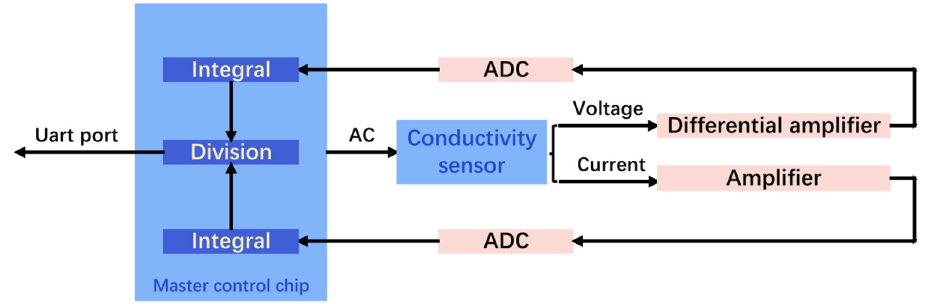
Figure 6. The designed circuit scheme of the four-electrode conductivity sensor. The signal is col- lected by ADC and processed by main control